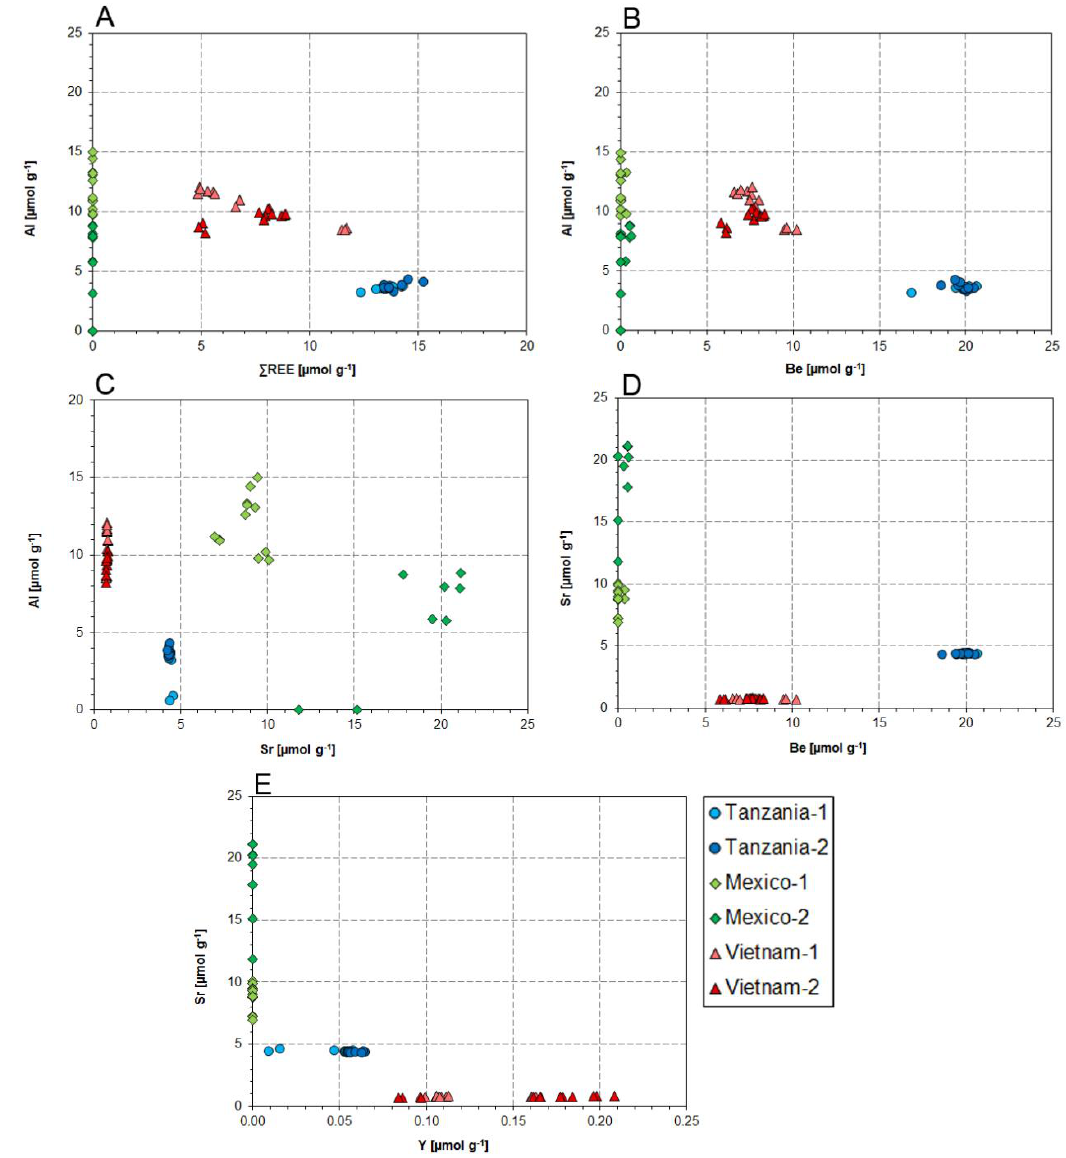
Figure 2. Molar abundance of Al versus ( A ) ∑REE, ( B ) Be, and ( C ) Sr, and Sr versus ( D ) Be and ( E ) Y. Aluminum is negatively correlated with ( A ) REEs, ( B ) Be, and ( D ) partly Sr, while Sr correlates negatively with ( D ) Be and ( E ) Y.